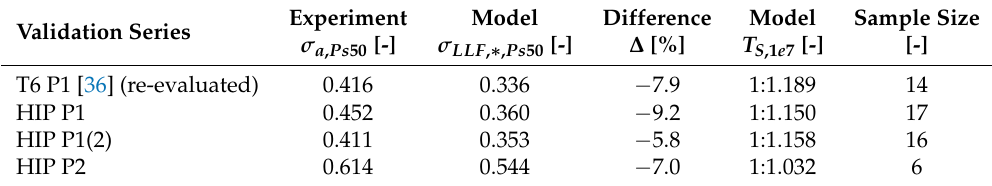
Figure 11. Long life fatigue strength assessment result of the validation series HIP P1. Table 7. Validation series results and re-evaluation of the T6 P1 validation series from